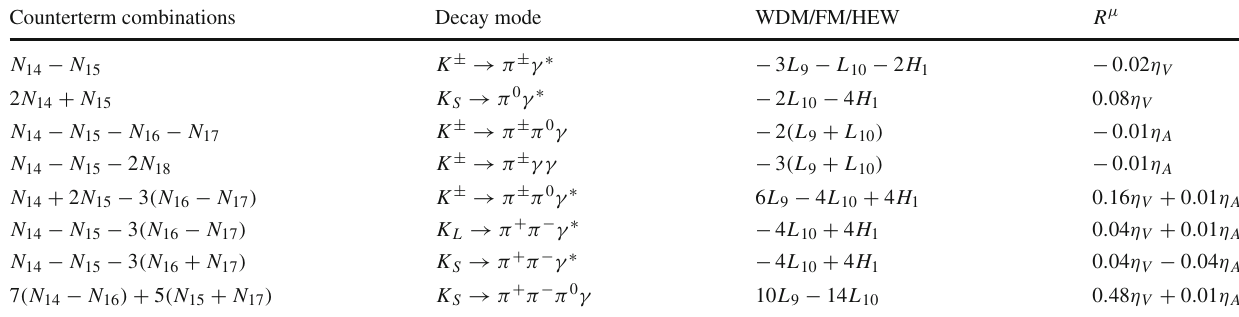
Table 3 Predictions of different counterterm combinations by two sets of models. On the third column we show the results of the weak defor- mation model (WDM), factorization model (FM) and holographic elec- troweak model (HEW), which yield the same predictions. On the fourth